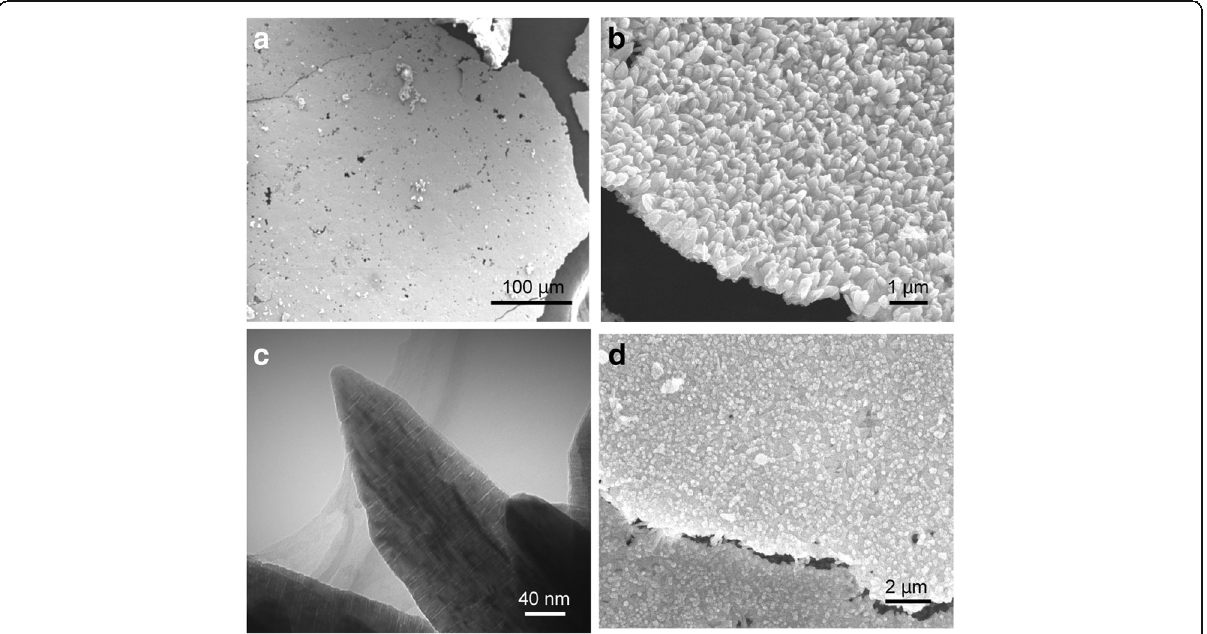
Fig. 1 SEM images of the VO 2 2D microarrays ( a ) and the surfaces formed in aqueous ( b ) and organic ( d ) phase. TEM image of the mesoporous